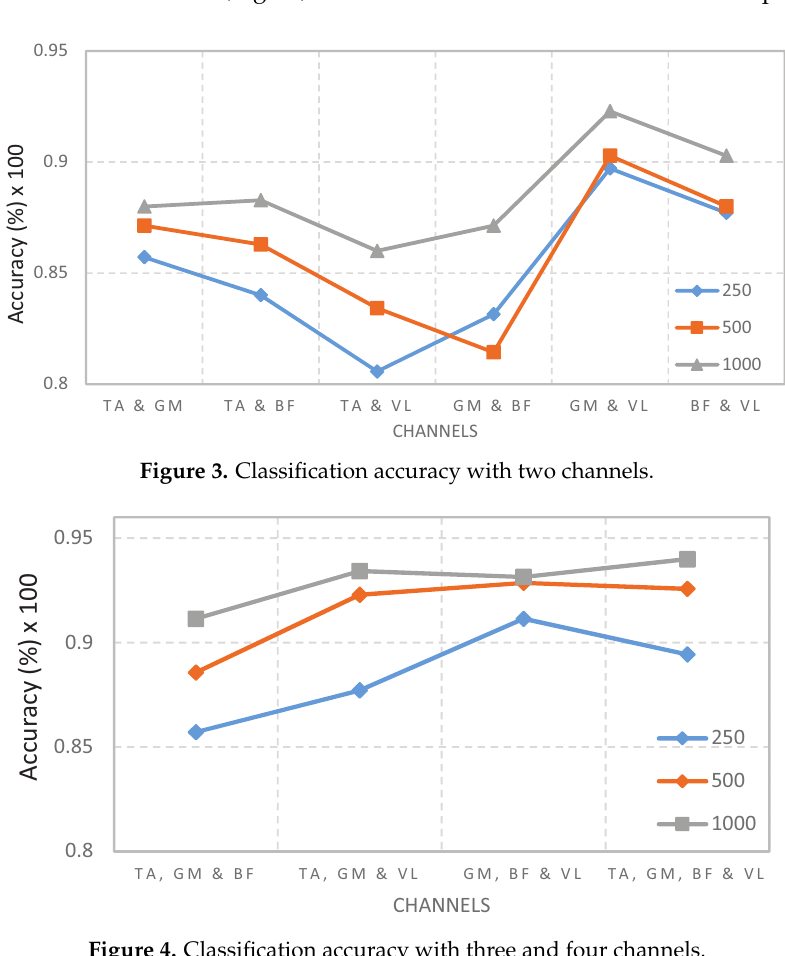
Figure 4. Classification accuracy with three and four channels.